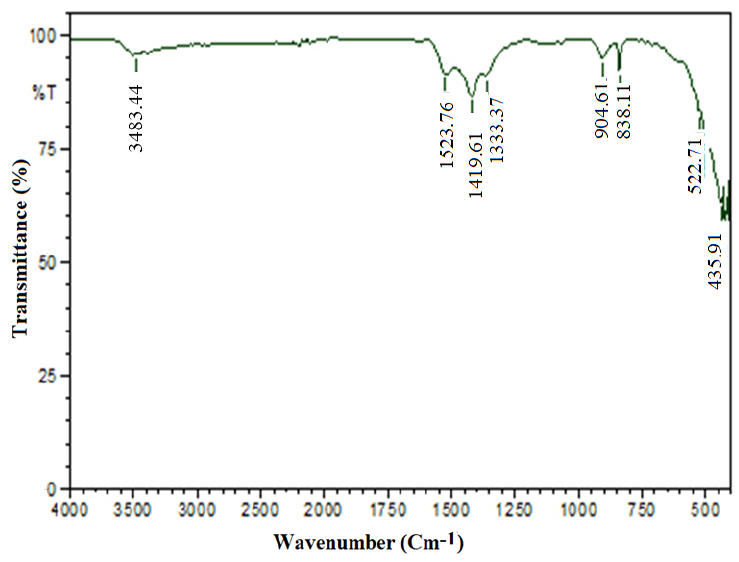
Figure 3. FTIR spectrum of synthesized ZnONP.